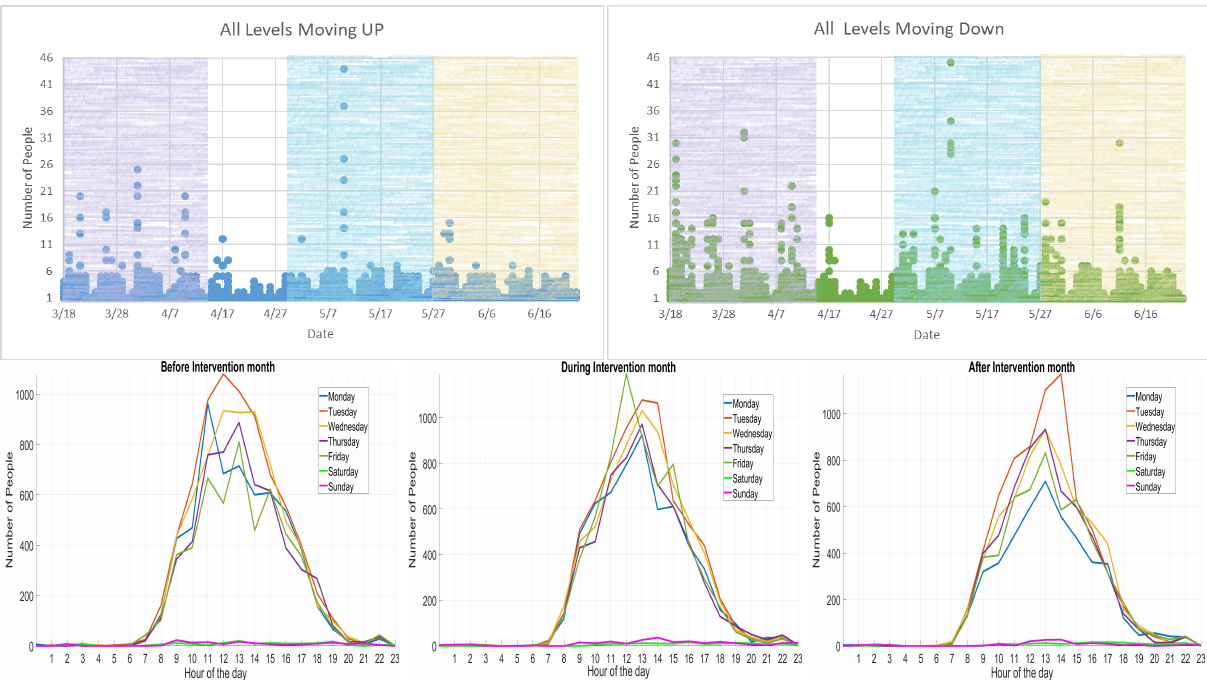
Figure 3: Top Panel:Total number of people using the stairs: before intervention month (purple), during intervention month (blue), and after intervention month (yellow). Bottom panel: Total number of people using the stairs: before intervention month (purple), during intervention month (blue), and after intervention month (yellow) usage of stairs is also observed on the weekends. The